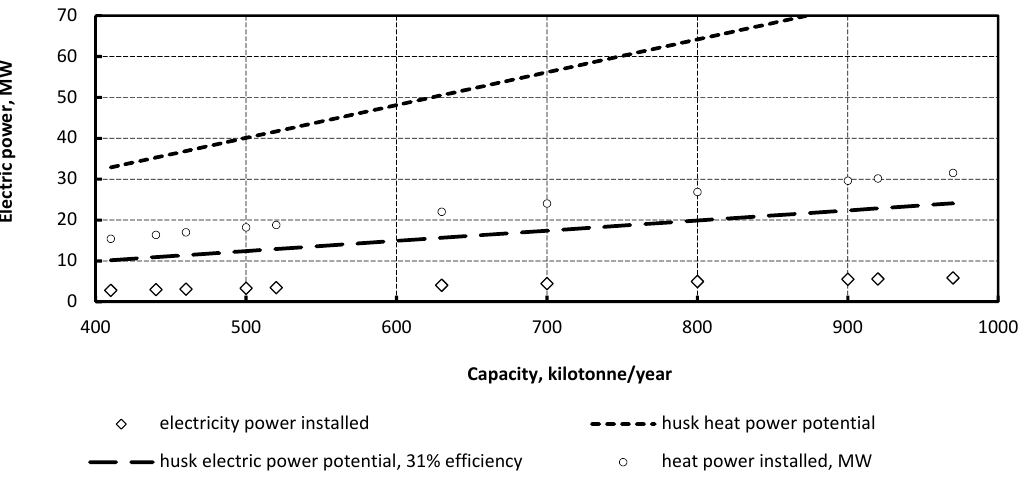
Figure 6. Installed and potential electric power vs. sunflower oil refinery capacity.